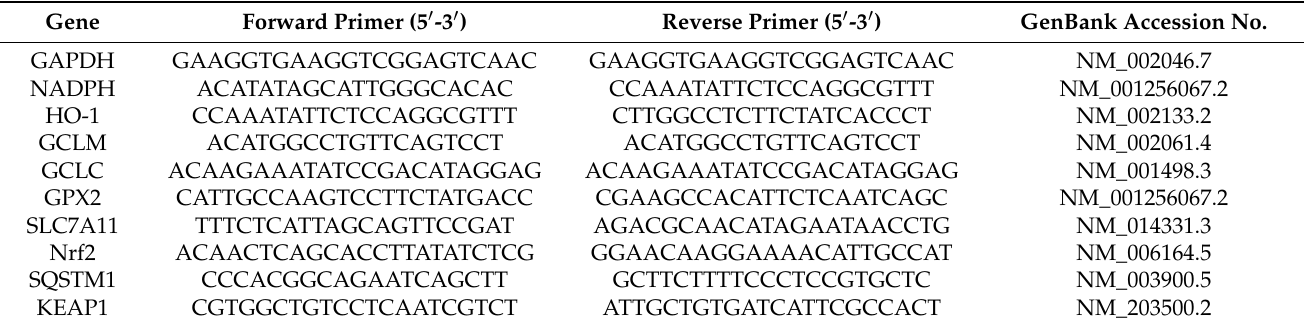
Table 1. Real-time quantitative PCR primers used in this